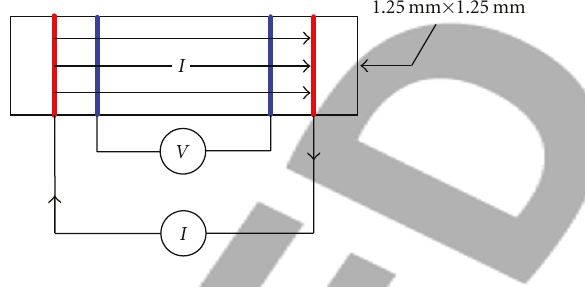
Figure 3: Electrode instrumentation for the 4-point probe method of resistivity measurement.